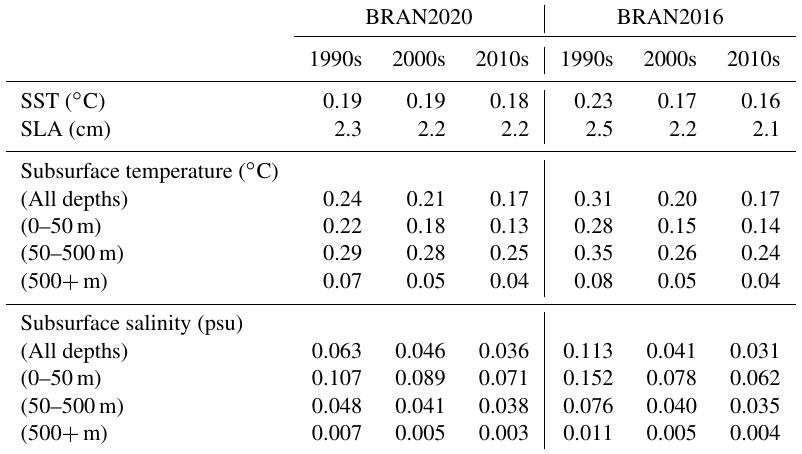
Table 4. Decadal averages of differences between the mean absolute values of background and analysis innovations for BRAN2020 and BRAN2016. These statistics provide an indication of how the errors grow between each analysis cycle. Fast error growth may indicate that analyses are overfit or that the observing system is too sparse to adequately constrain the